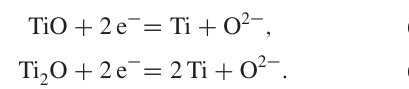
O, (e) Ti metal and (f) oxygen 2